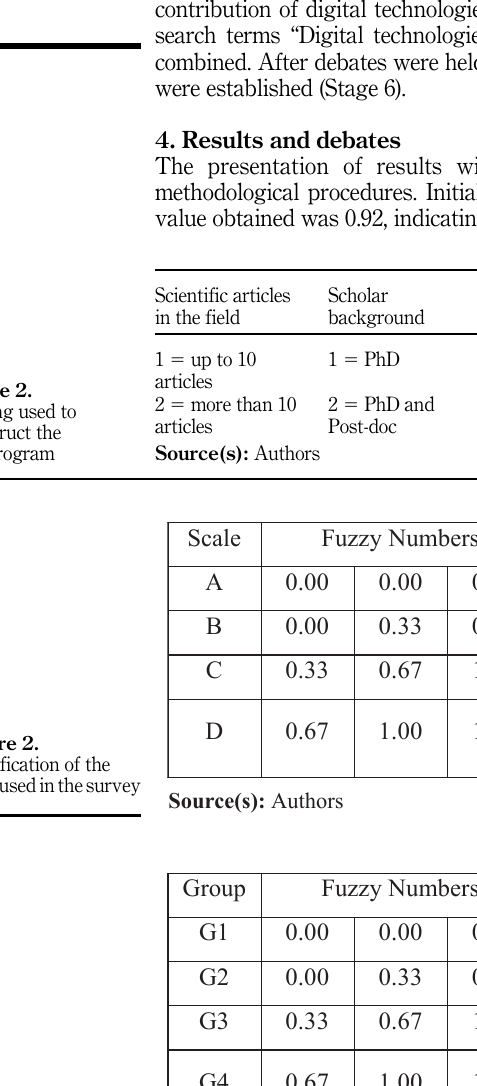
Figure 3. Fuzzification of the groups